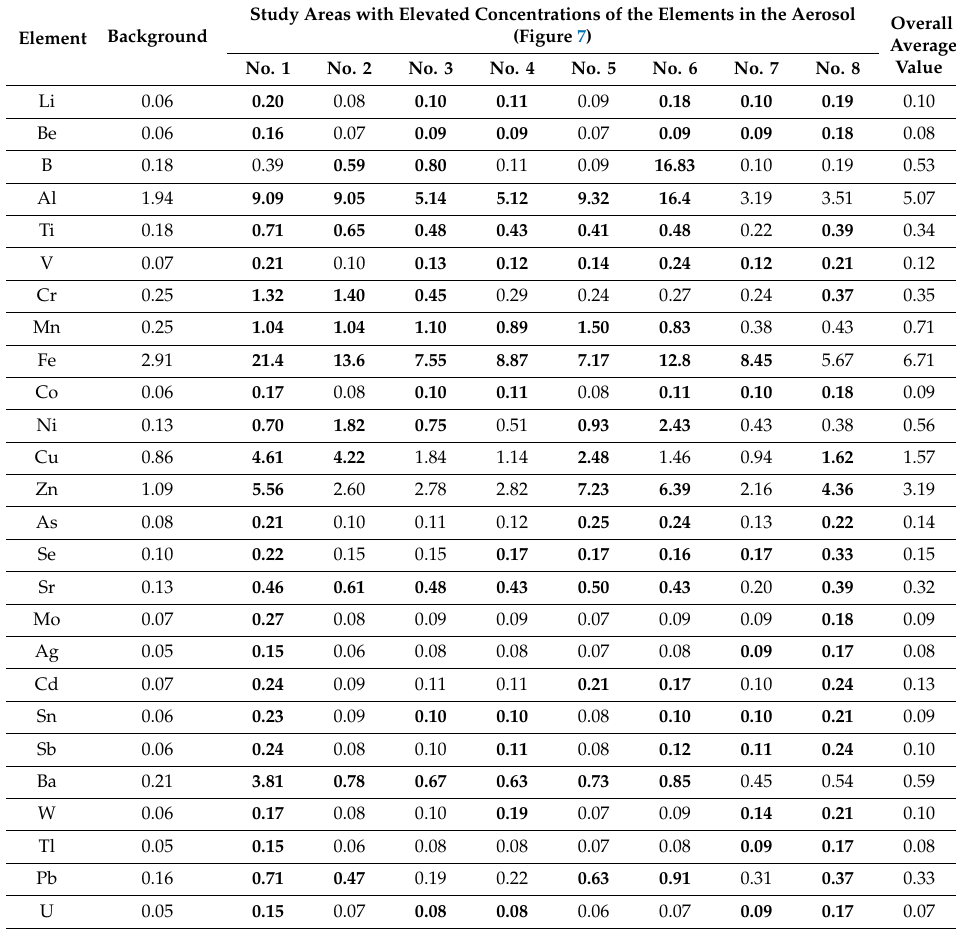
Table 7. Elemental composition of the aerosol in the near-water atmospheric layer above Lake Baikal along the route of the RV «Akademik V.A. Koptyug» from 24 July to 4 August 2019, ng / m 3 . (The values in bold type those exceeding the average